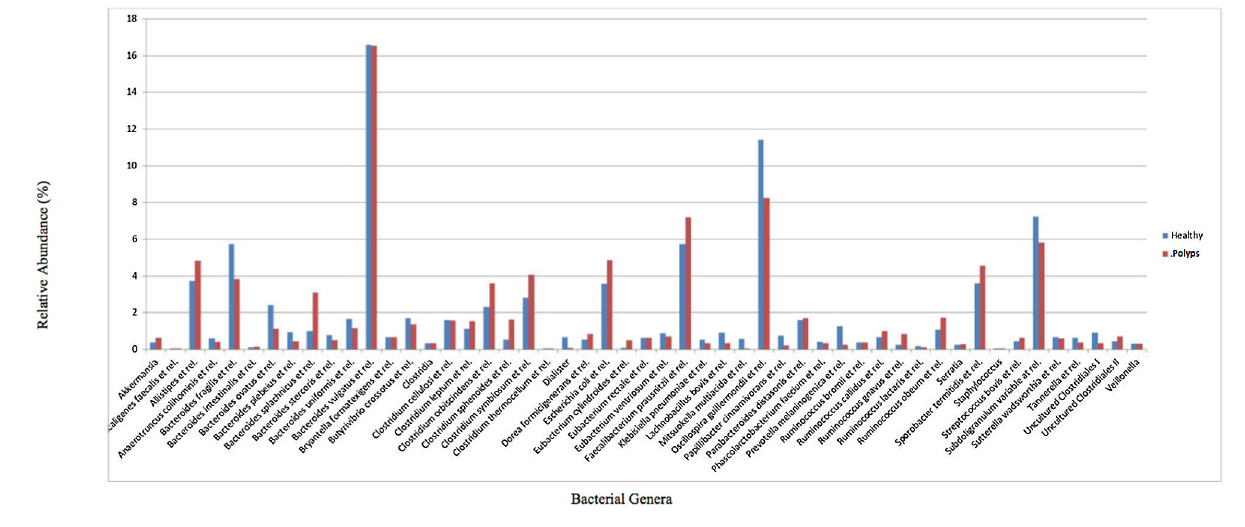
Figure 3. Barplots showing the relative abundances of bacterial groups at genus-like level in healthy and colon polyps patients’ samples determined by HITChip profiling. Bacterial groups that are at least 1% in one of the samples are shown.